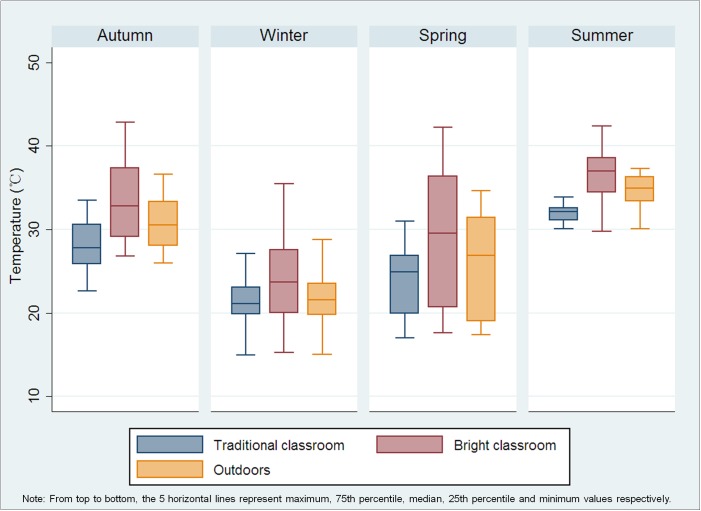
Boxplots of temperature outdoors, in the Bright Classroom and in the traditional classroom over the four seasons.